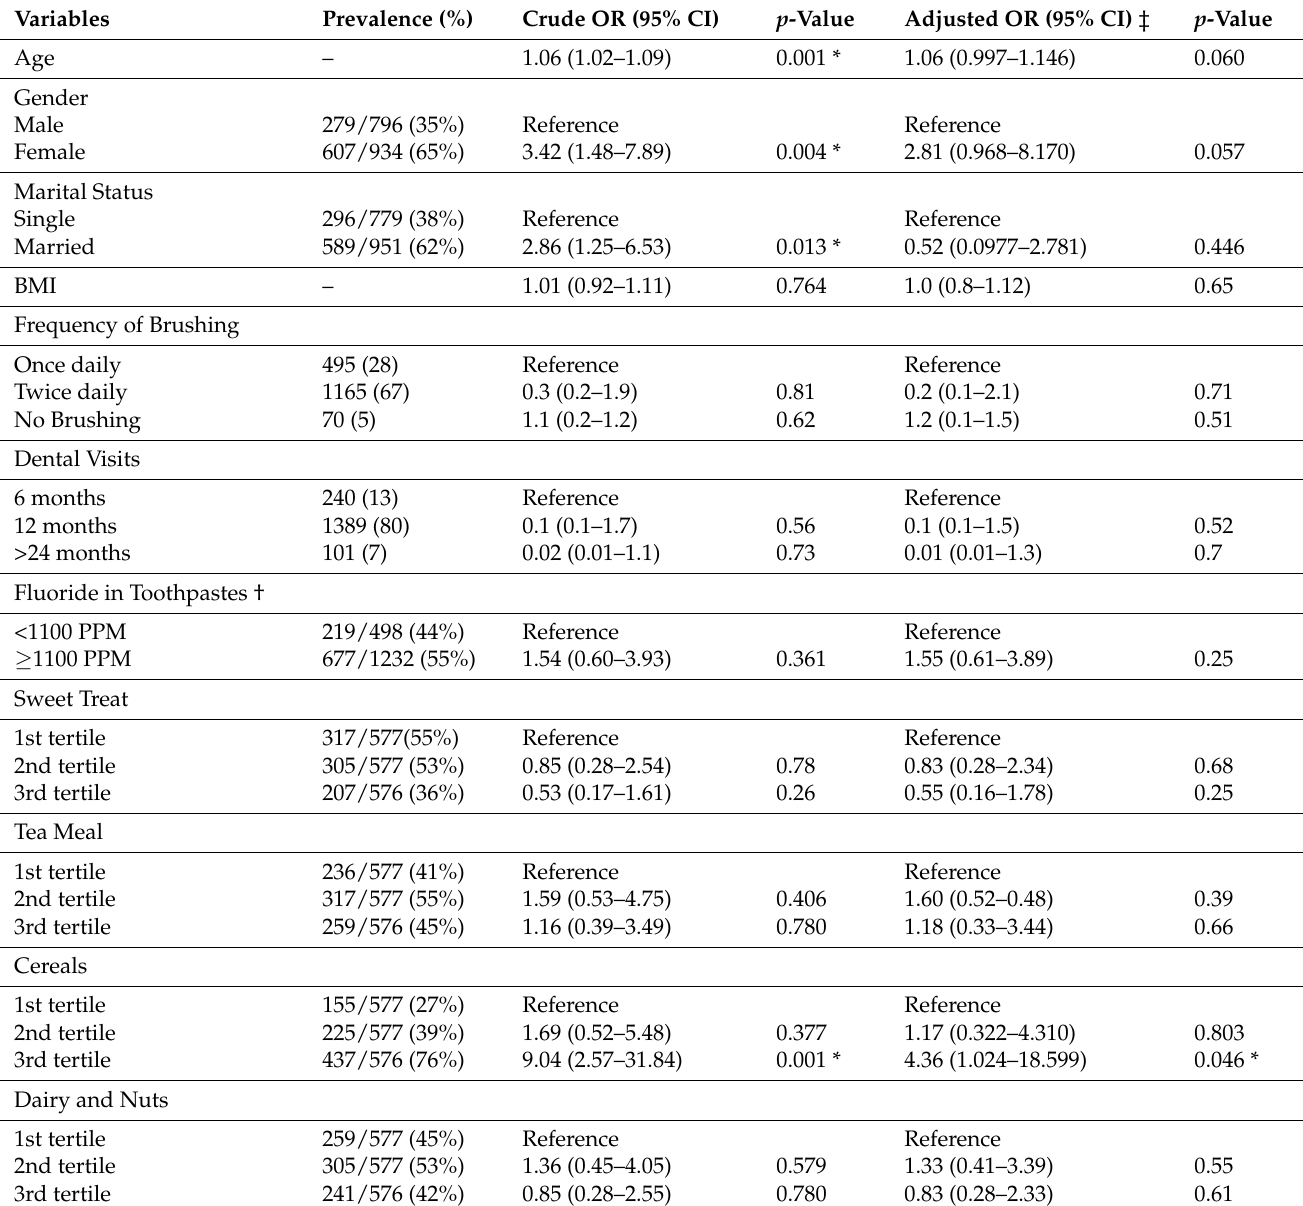
Table 3. Odds ratios and 95% confidence intervals for variables predicting ≥ 5 DMFT in